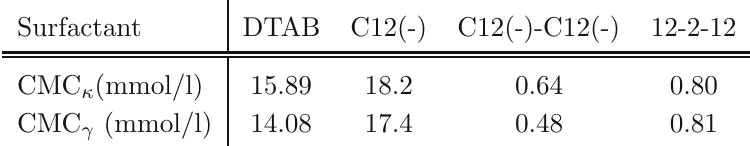
Table 4 Comparison of CMCs determined from electric conductivity and surface